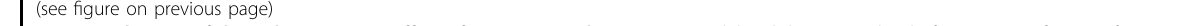
Fig. 6 Mechanism of the radiosensitizing effect of LINC-PINT. a , b LINC-PINT modulated the protein level of DNA-PKcs. After transfection, cells were treated with or without 8-Gy radiation and subjected to qRT-PCR ( a ) and western blot ( b ) for DNA-PKcs. Data represent the mean ± SEM from three independent experiments. Statistical signi fi cance was calculated using a two-sided t test. * P < 0.05, ** P < 0.01, *** P < 0.001. c , d Representative fl uorescence images ( c scale bars, 10 µm; blue, DAPI; red, pDNA-PKcs; green, Ku80) and quanti fi cation ( d n = 3 biologically independent samples) of colocalization between pDNA-PKcs (Ser2056) and Ku80 in HNE1 and HONE1 cells. Pearson ’ s R values were analyzed by Image J. e The molecular pathway of LINC-PINT-mediated radiosensitization. On the one hand, LINC-PINT was responsive to DNA damage, inhibiting DNA damage repair through ATM/ATR-Chk1/Chk2 signaling pathways. On the other hand, LINC-PINT increased radiosensitivity by interacting with DNA-PKcs and negatively regulated the expression and recruitment of DNA-PKcs. Therefore, LINC-PINT may confer radiosensitivity to